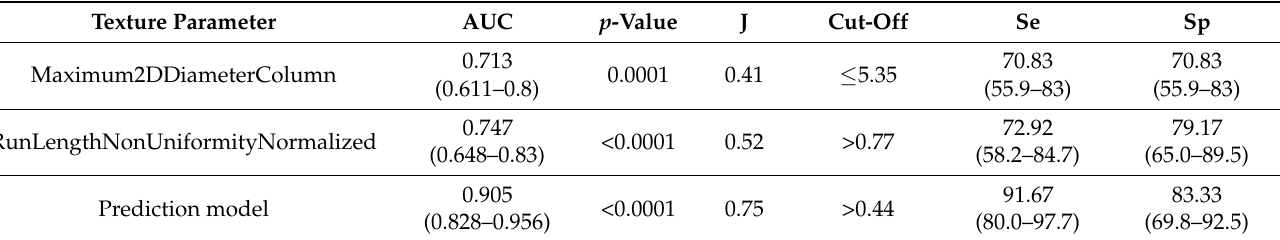
Table 4. The diagnostic performance of the selected radiomic features and of the combined prediction model in differentiating between normal LG and LG of patients with pSS.